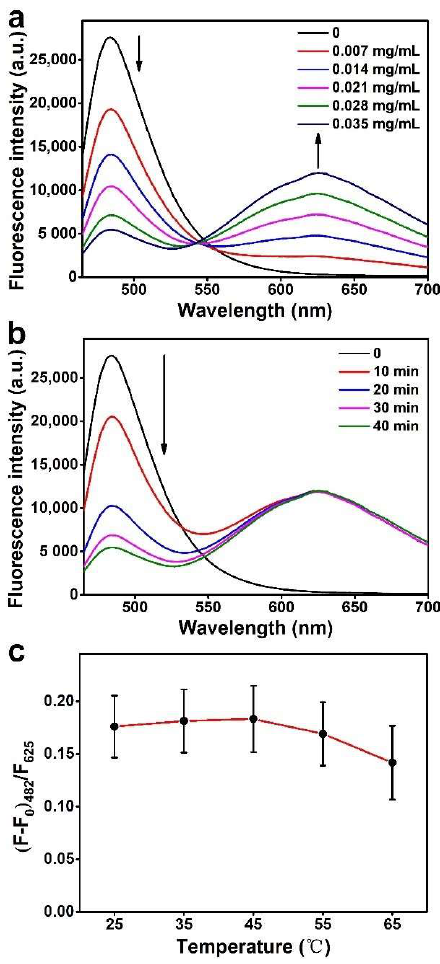
Figure 4. ( a ) The effect of the amount of MWCNTs@Au NCs on the fluorescence signals of the biosensing system. ( b ) The variation of the fluorescence of Atto-425 with the mixing time of the probe and MWCNTs@Au NCs. ( c ) The effect of incubation temperature on the fluorescence signals ( n = 3, mean ± s.d.).